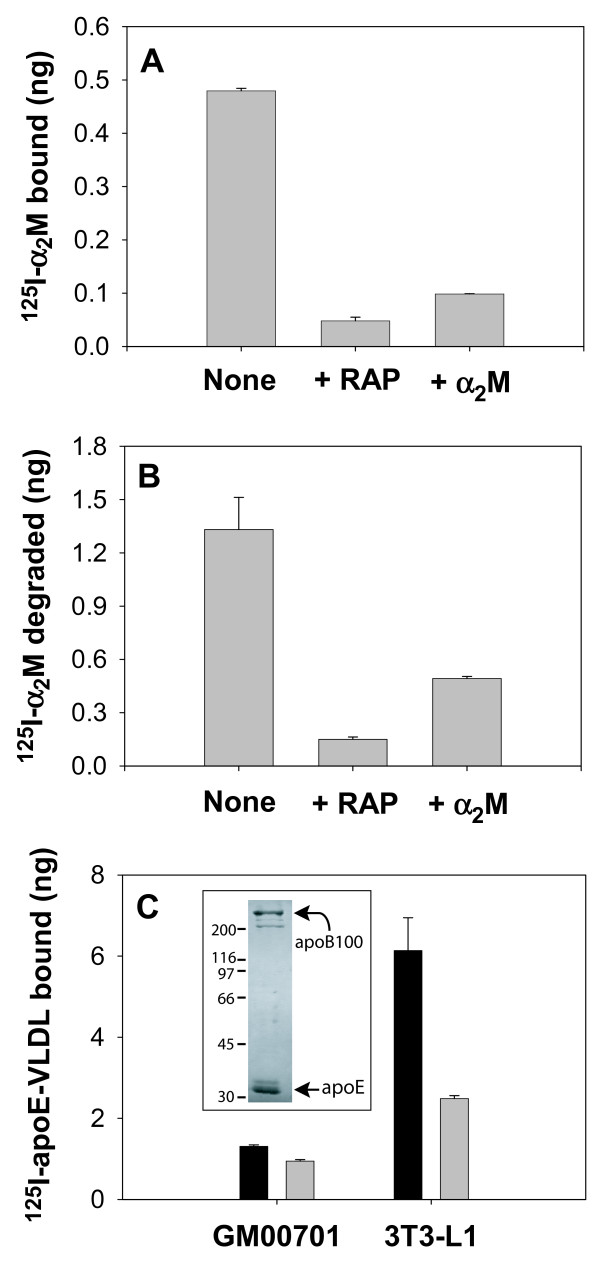
125I-α2M and 125I-apoE-VLDL handling by GM00701 cells. GM00701 cells were incubated with 125I-α2M (1 μg/ml) at 4°C for 3 h (A) or at 37°C for 1 h (B) in the absence or presence of recombinant human RAP-GST (50 μg/ml) or unlabeled α2M (10 μg/ml). (C) GM00701 and 3T3-L1 cells were incubated with 125I-apoE-VLDL (2 μg/ml) supplemented with 3 μg/ml apoE at 4°C for 3 h in the absence (solid bars) or presence (shaded bars) of unlabeled apoE-VLDL (100 μg/ml). After the indicated incubation time, 125I-ligand bound to cells at 4°C was quantitated by scintillation counting following extraction of cells with 0.1 M NaOH. 125I-α2M degradation was quantitated following TCA precipitation as described in Methods. Error bars represent standard deviations of triplicate points. Inset, purified VLDL was separated by 7.5% SDS-PAGE and proteins were stained with Coomassie R. Molecular mass markers shown at left are in kD.